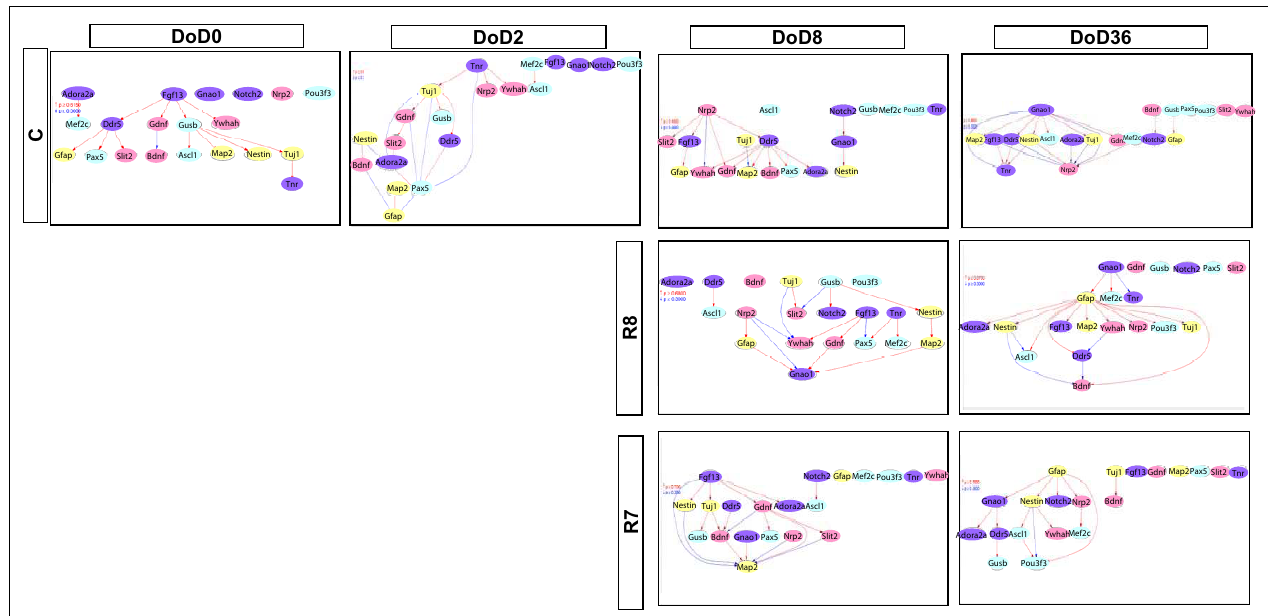
FIGUREA3 | Gene interaction networks of the enrichment gene set (set 3) in mESCs, EB, and NP of neuronal differentiation. The optimized network was generated at p > 0.300. Red indicates that parent genes up-regulate children genes. Blue indicates that parent genes down-regulate children